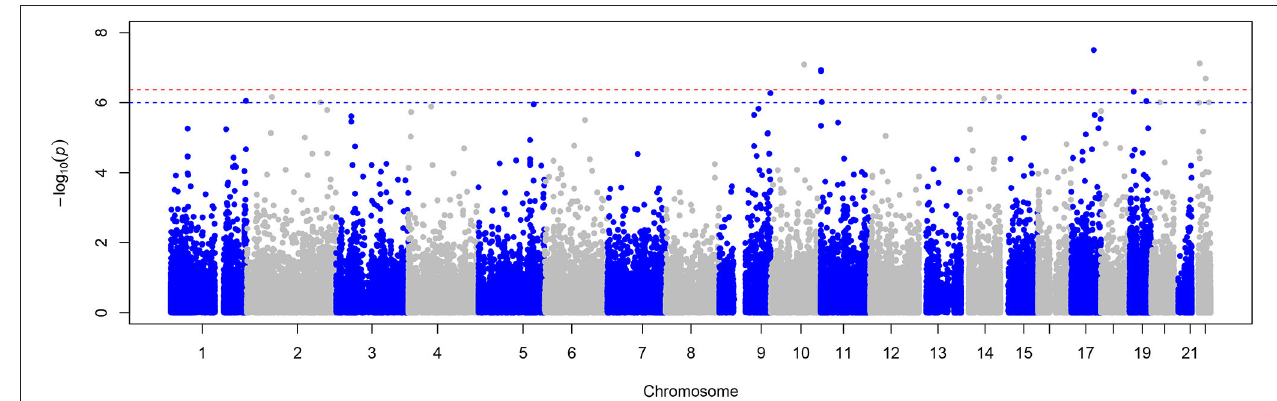
FIGURE 1 | Manhattan plot of the meta-analysis of symptoms of sleep apnea. This plot shows − log 10 transformed p -values (y-axis) for all SNPs present in the meta-analysis according to their position on each chromosome (x-axis). The red dashed line represents the Bonferroni corrected p -value threshold for significance ( p < 4.3 × 10 − 7 ) and the blue dashed line indicates the threshold for suggestive associations ( p < 1.0 × 10 − 6 ).